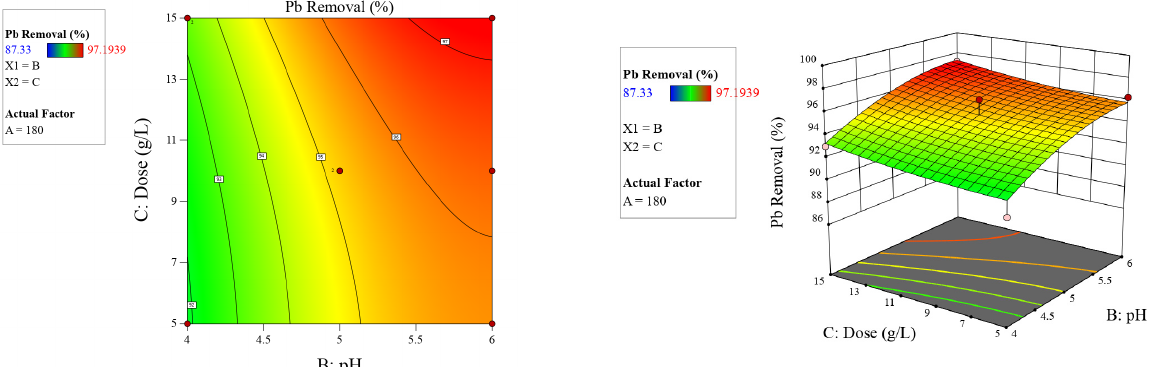
Figure 7. Two-dimensional contour and three-dimensional surface plots on the relation between contributed factors (pH and dose) and Pb 2+ removal by Odaracha adsorbent. and dose) and Pb 2+ removal by Odaracha